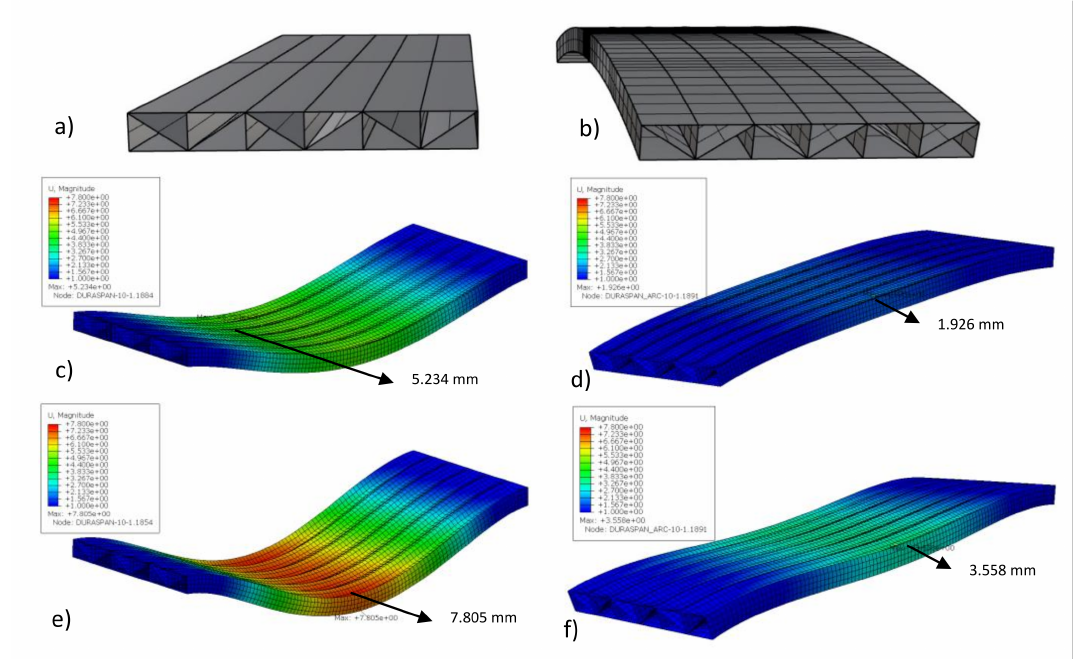
Figure 7. Geometry of: ( a ) Duraspan and ( b ) Duraspan in an arch. Deformation for: ( c ) Duraspan (laminate); ( d ) Duraspan (laminate) in an arch; ( e ) Duraspan (quasi-isotropic); ( f ) Duraspan (quasi-isotropic) in an arch.